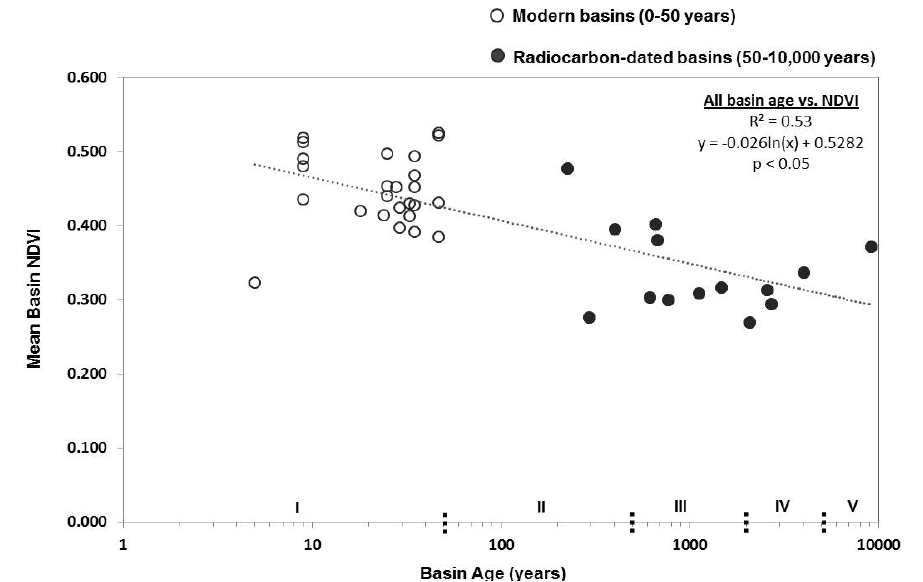
Figure 4. Plot of mean basin NDVI observed on 13 July 2009 against basin age showing a logarithmic relationship for the period of 0–10,000 years. Basin age class is shown as: I. Modern basins; II. Young basins; III. Medium age basins; IV. Old basins; and V. Ancient basins.